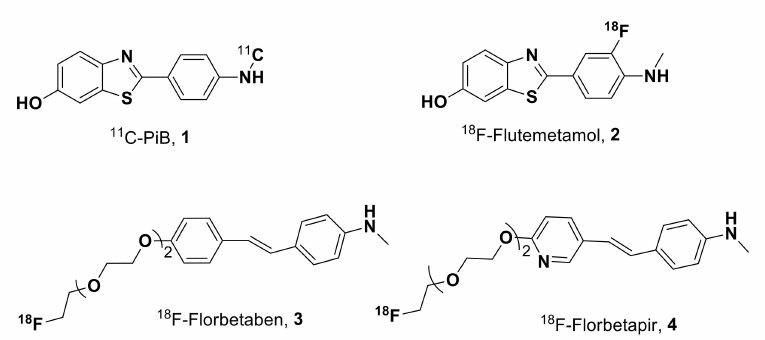
Figure 1. The chemical structures of some clinically used AD tracers.